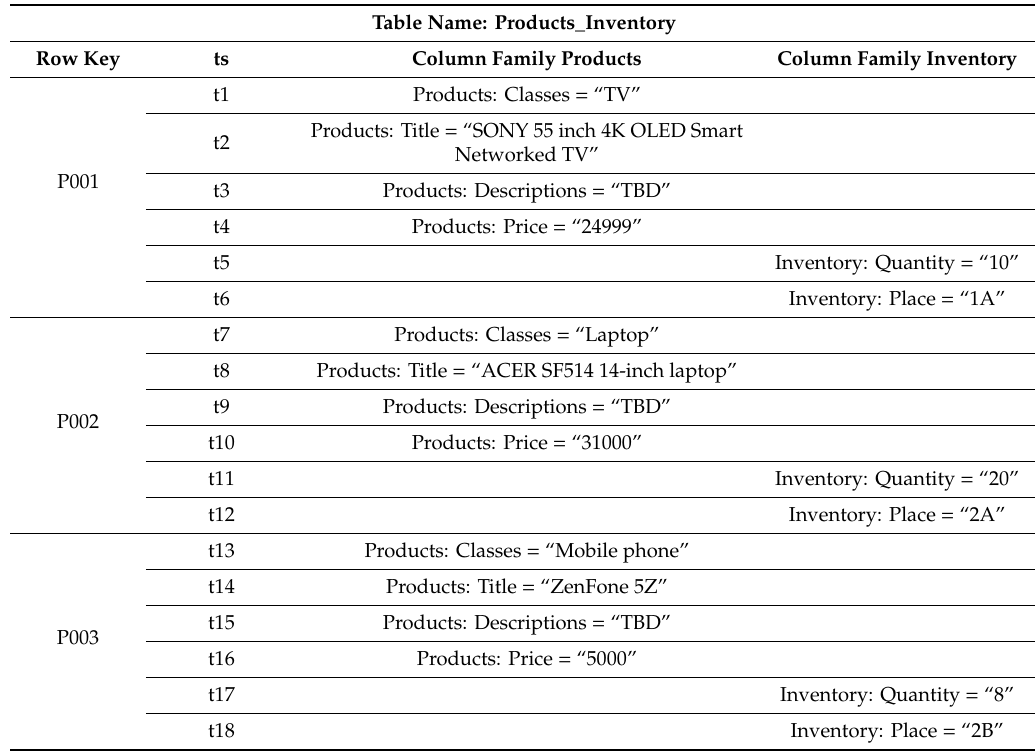
Table 3. An example of a data table in wide column store. Table Name: